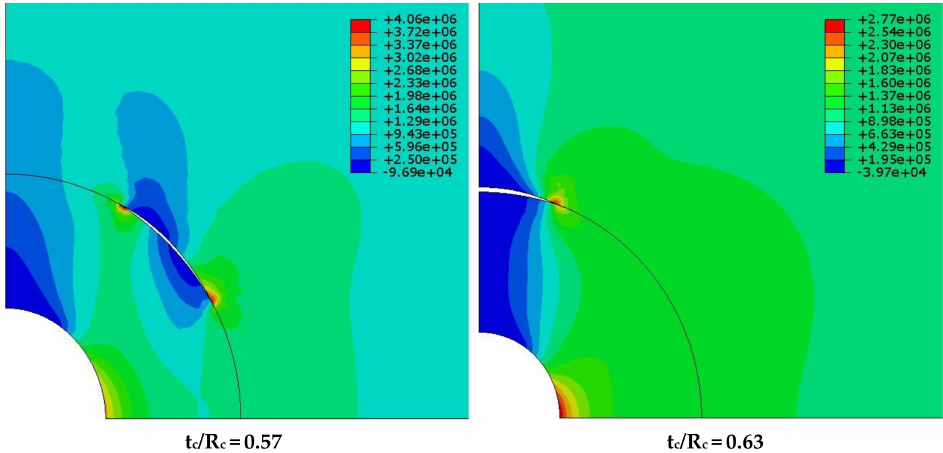
Figure 12. Onset of debonding: transition in the mode of initiation of the interfacial crack (color scale: maximum principal stress, in Pa) (Adapted with permission from MDPI [235]). Annotations: R c = radius of half-length of the plate, t c = the capsule wall thickness, and t c /R c = geometrical